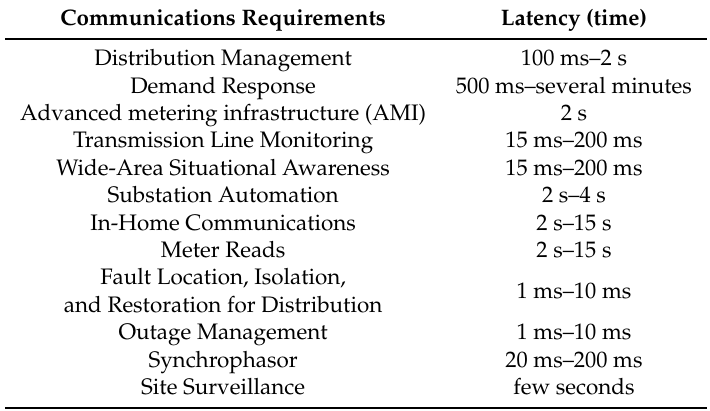
Table 1. Communication requirements for a microgrid